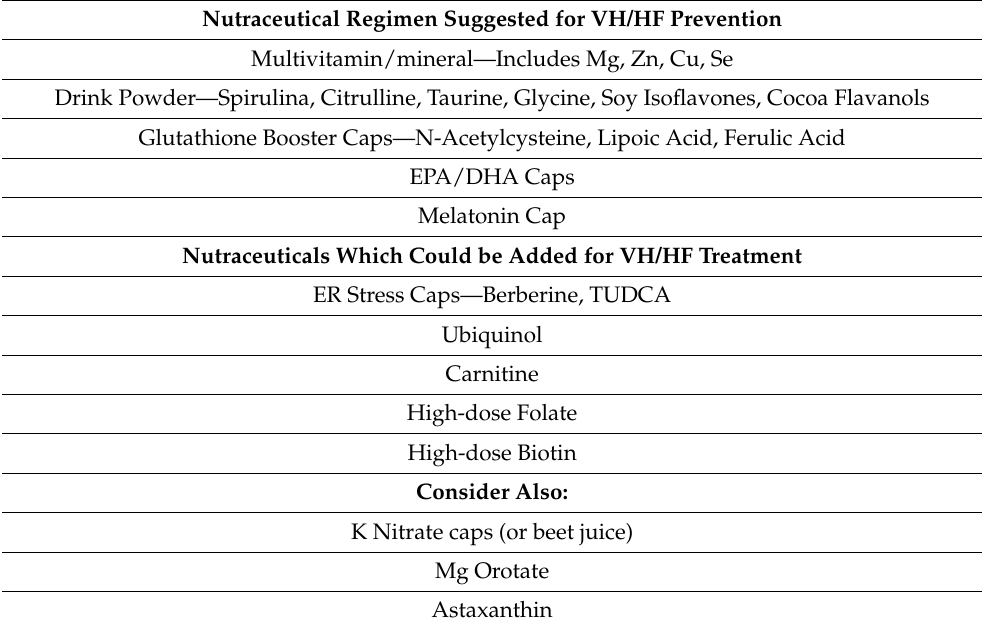
Table 2. Practical Guidance for Heart-Protective